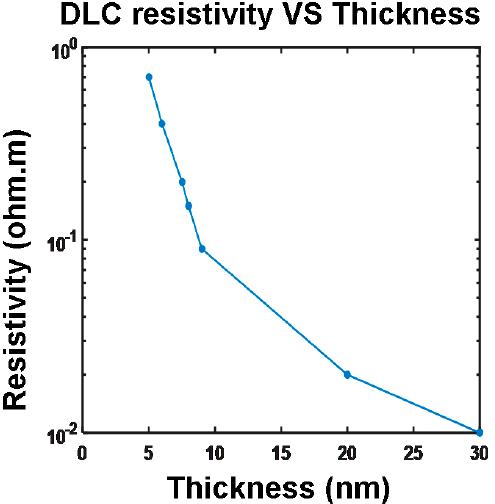
Figure 8. The dependence of the DLC film thickness on its electrical resistivity. Reprinted with permission from [29]. Copyright De Gruyter, 2016.